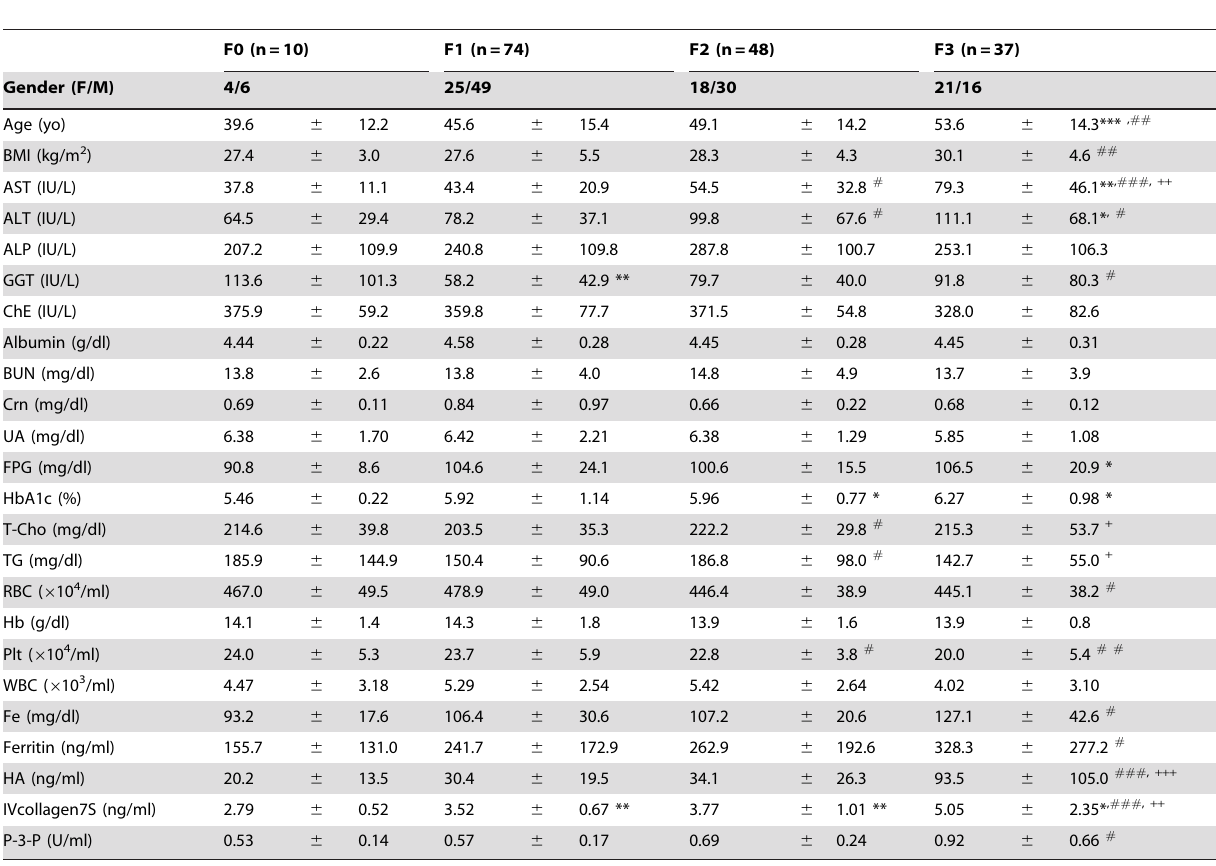
Table 1. Clinical and physiological characteristics of patients with NAFLD in the four stages of hepatic fibrosis.